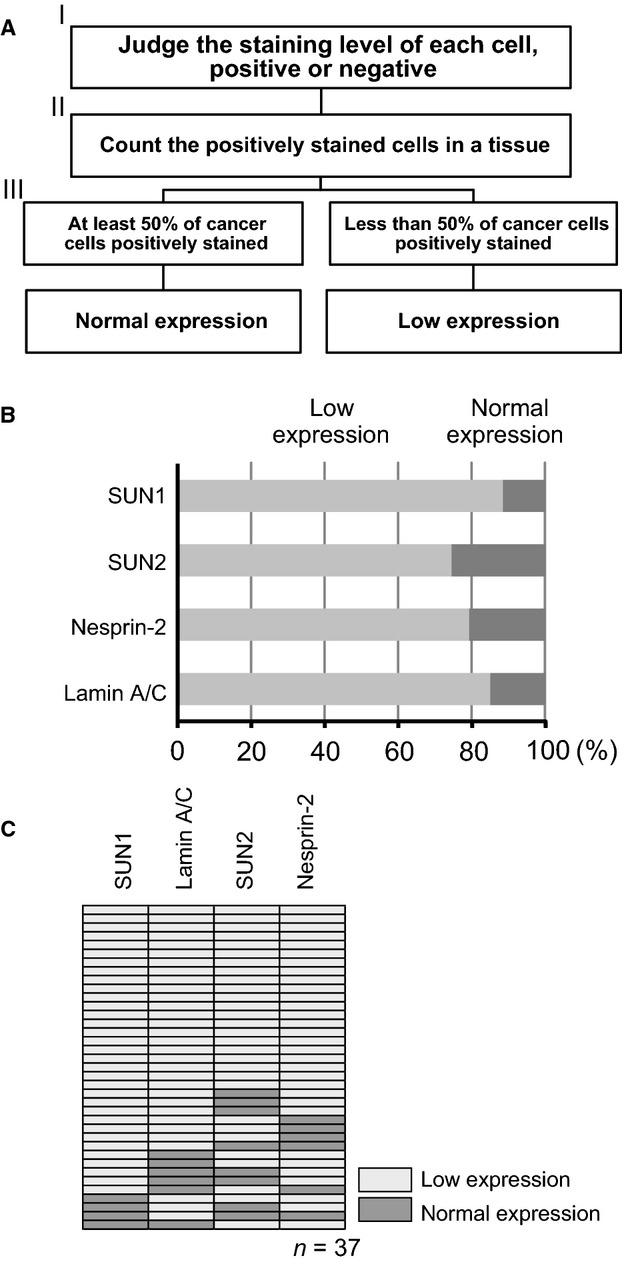
Quantitation of staining of LINC complex and nuclear lamina components. (A) A method for quantitation of LINC complex and nuclear lamina protein expression in cancerous regions. The staining pattern of each protein in tumor tissue was used to categorize cells into normal and low expression groups. Staining of mammary epithelial cells in a cancer-associated noncancerous region in the same tissue was used as an internal positive control. The staining patterns were classified into normal and low expression based on the percentage of positively stained cancer cells in the tissue. (B) Bars indicate the percentages of tissues in the low expression and normal expression groups for the indicated antibodies. (C) This panel indicates the expression of each protein. Each horizontal line represents the expression in one patient. Dark gray and light gray boxes indicate normal and low expression, respectively. LINC, linker of nucleoskeleton and cytoskeleton.